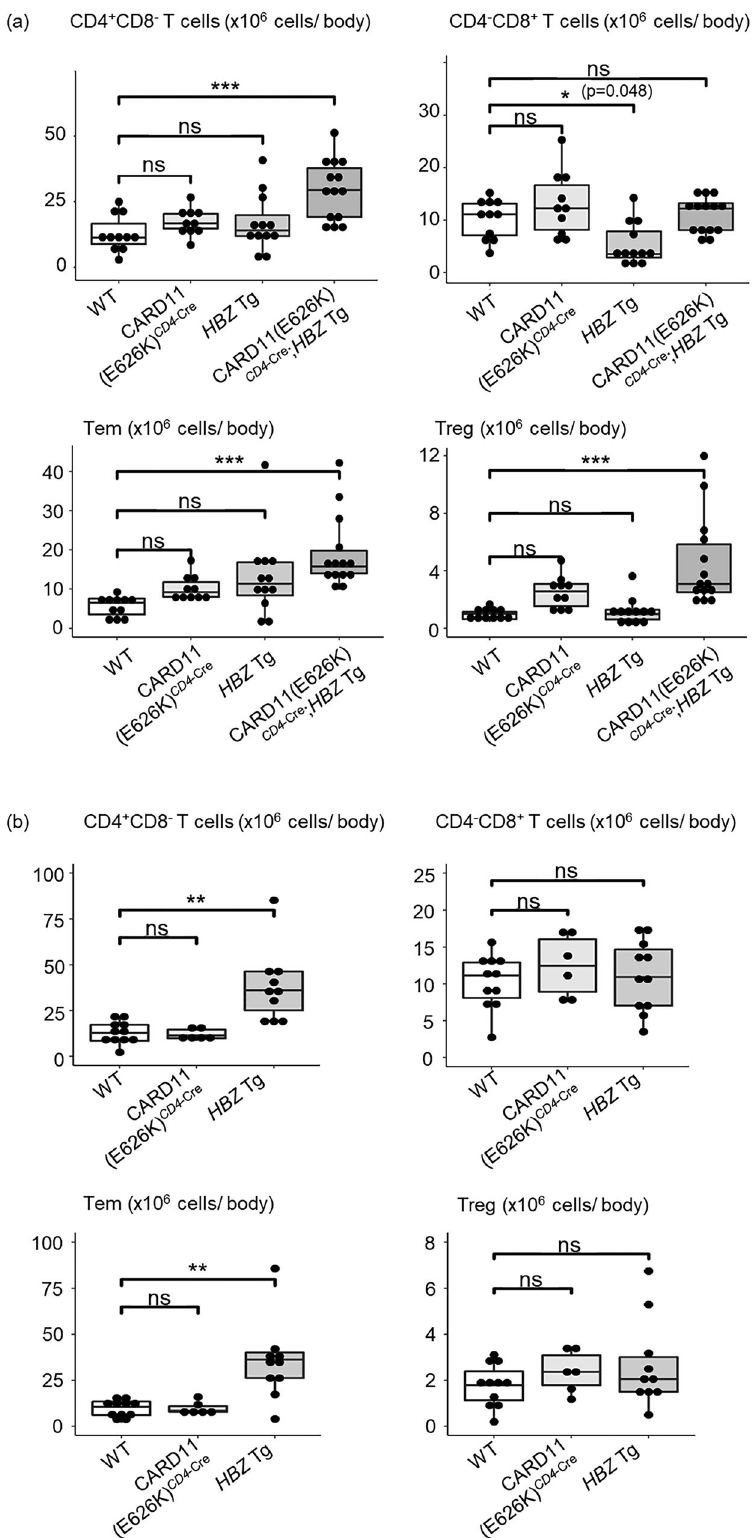
Fig. 5 Increased numbers of CD4 + T cells and their subsets per body in mutant mice. Absolute numbers of CD4 + CD8 - T cells, CD4-CD8 + T cells, CD4 + CD44 + CD62L − effector/memory T cells (Tem), and CD4 + CD25 + regulatory T cells (Treg) per mouse in wild type (WT) ( n = 11), CARD11(E626K) CD4 -Cre ( n = 10), HBZ Tg ( n = 12), and CARD11(E626K) CD4 -Cre ; HBZ Tg ( n = 14) mice at 6 months after birth ( a ), and those in WT ( n = 11), CARD11(E626K) CD4 -Cre ( n = 6), and HBZ Tg ( n = 11) mice at 12 months after birth ( b ). p values were calculated by the Tukey test after one-way ANOVA, and *, **, and *** represent p values less than 0.05, 0.01, and 0.001,